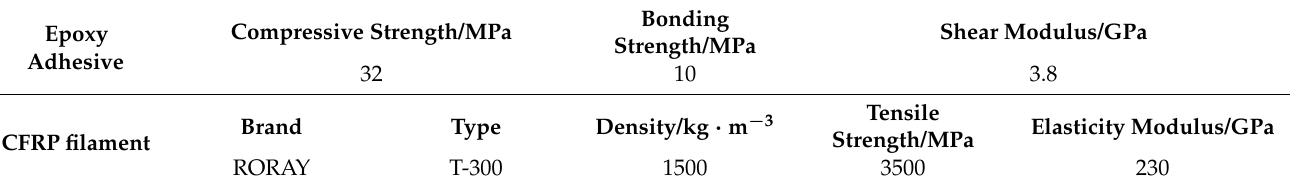
Figure 2. Original materials and CFRP bars test: ( a ) Carbon fiber filaments; ( b ) Manufactured CFRP bars: ( c ) Setup in tensile tests. Table 1. Properties of Epoxy Adhesive parameters and CFRP filament.